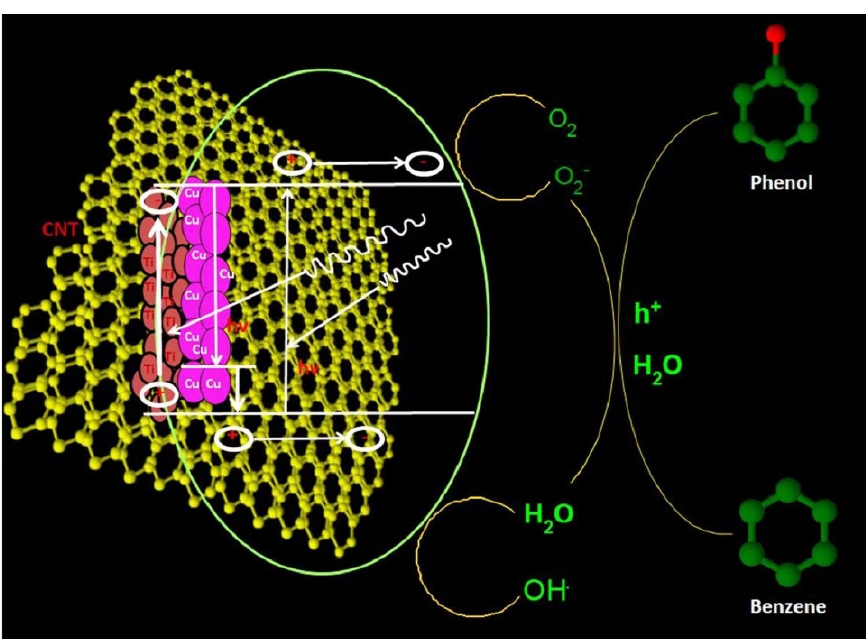
Figure 6. Proposed mechanism of photocatalytic benzene oxidation to phenol over copper/titanium dioxide/CNT catalysts. Reprinted with permission from ref. [93] . 2018 Elsevier.